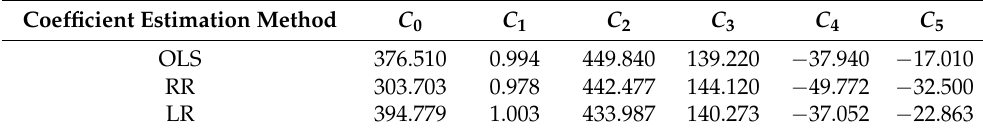
Table 5. Regression results of three coefficient estimation methods.